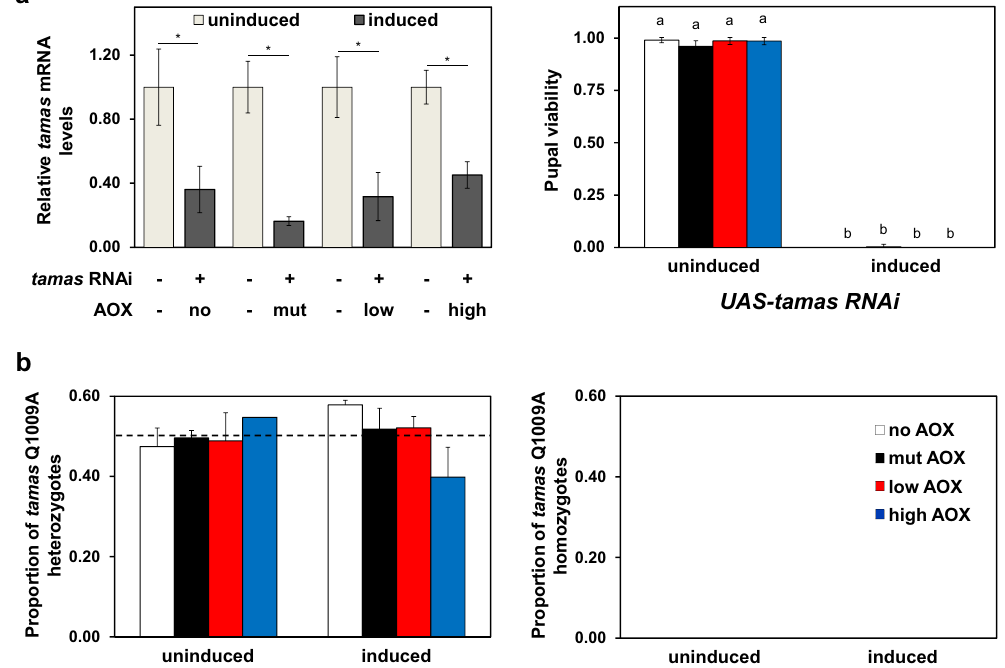
Figure 4. AOX does not rescue the developmental defects caused by genetic disturbances of pol γ . ( a ) Transcript levels of tamas , the coding gene for the catalytic subunit of pol γ ( left panel ), were measured as described in the Methods. Pupal viability ( right panel ) was measured as the mean ratio between the number of adults eclosed and the number of pupae per vial ( + / − standard deviation). Uninduced and induced indicate samples originated from the crosses UAS-tamas RNAi ; UAS-AOX X w 1118 and UAS-tamas RNAi ; UAS-AOX X daGAL4 , respectively. ( b ) Viability of the tamas Q1009A lines was measured as the mean ratio between the number of wild-type adults and the total number of individuals per vial ( + / − standard deviation). Left panel , progeny originated from crosses using tamas Q1009A /CyO; UAS-AOX and w 1118 (uninduced) or daGAL4 (induced) to generate a heterozygous tamas Q1009A progeny, serving as controls. The expected Mendelian ratio of wild-type adults (carrying one tamas Q1009A allele) for these crosses is 0.5 (dashed line). Right panel , progeny originated from crosses using tamas Q1009A /CyO; UAS-AOX and tamas Q1009A /CyO (uninduced) or tamas Q1009A /CyO; daGAL4 (induced) to generate a homozygous tamas Q1009A progeny. The expected Mendelian ratio of wild-type adults (carrying two tamas Q1009A alleles) for these crosses is zero, as tamas Q1009A in homozygozity is lethal 29 . See Supplementary Fig. S6 for details of the genetic crosses. no AOX, mut AOX, low AOX and high AOX indicate respectively the constructs UAS-empty 3rd , UAS-mutAOX 3rd , UAS- wtAOX 7 . 1 21 and UAS-wtAOX F24 12 . * indicates statistical differences ( P < 0.05) according to Student’s t -tests. Letters a-b indicate significantly different statistical classes ( P < 0.05) according to one-way ANOVA, followed by the Tukey post-hoc test, applied separately for the data in ( a ) right panel , and ( b ) right and left panels . No significant differences were found ( P > 0.05) for the data shown in ( b